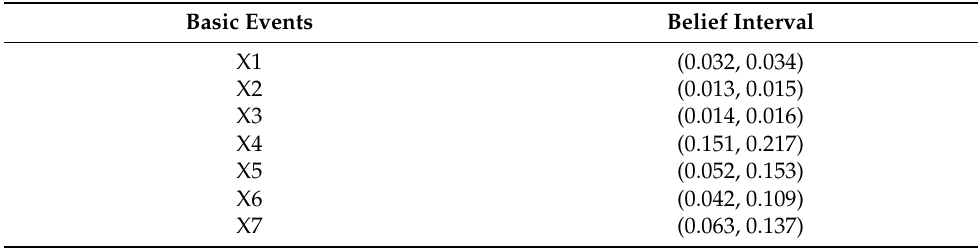
Table 5. Basic Event Trust